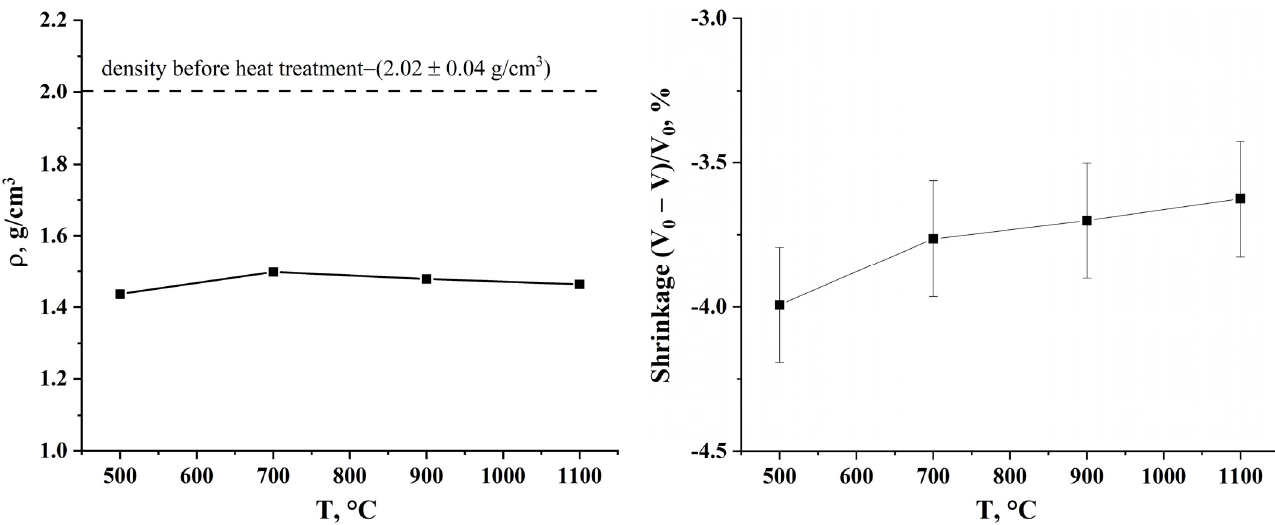
Figure 10. Apparent density (g/cm 3 ) and Volume shrinkage (V 0 − V/V 0 , %) of ceramic samples based on the tricalcium phosphate powder Ca 3 (PO 4 ) 2 and the aqueous solution of sodium silicate (Na 2 O · 2,87SiO 2 ) aq after heat treatment at 500 °C, 700 °C, 900 °C and 1100 °C.